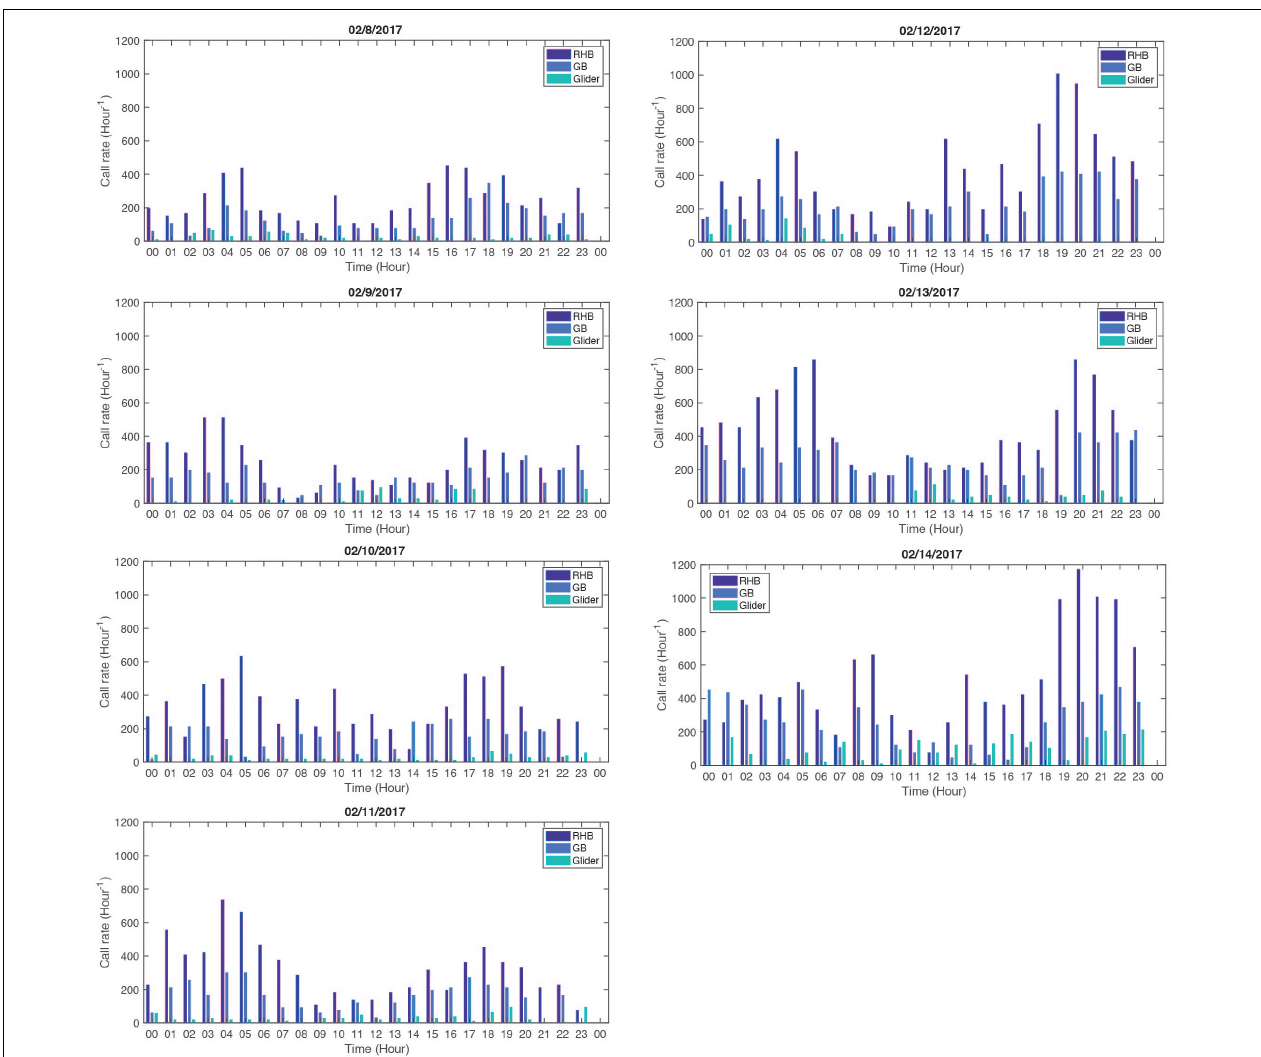
FIGURE 10 | Hourly CAS rate for each day of the wave glider survey, from 8 to 14 February, 2017 (full moon was on 11 February). Each daily graph shows the hourly CAS rate at RHB (dark blue), GB (light blue) and at the wave glider